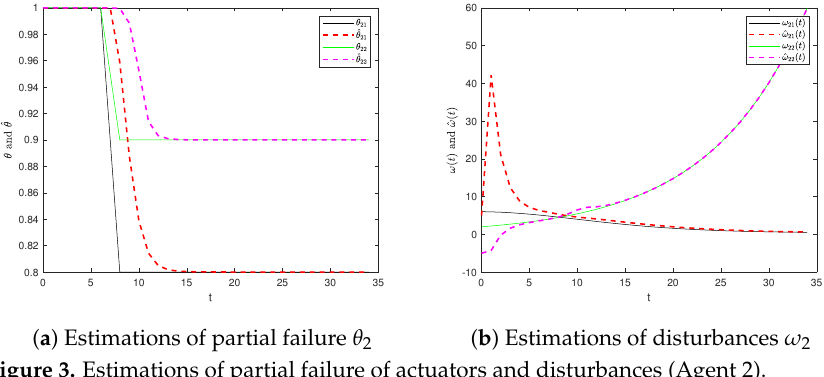
Figure 3. Estimations of partial failure of actuators and disturbances (Agent 2).